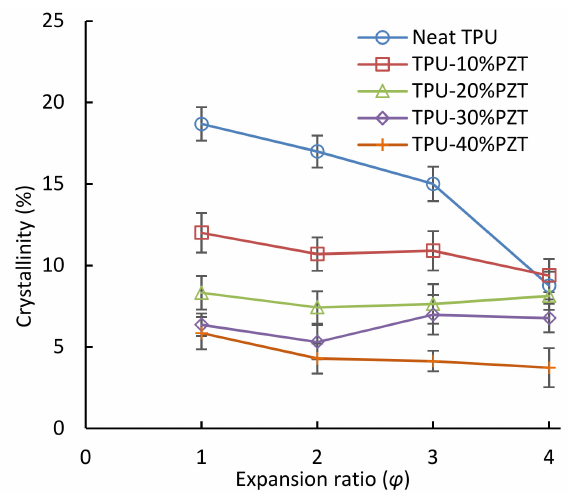
Figure 5. Total crystallinity of the TPU and TPU/PZT solid and foamed composites.